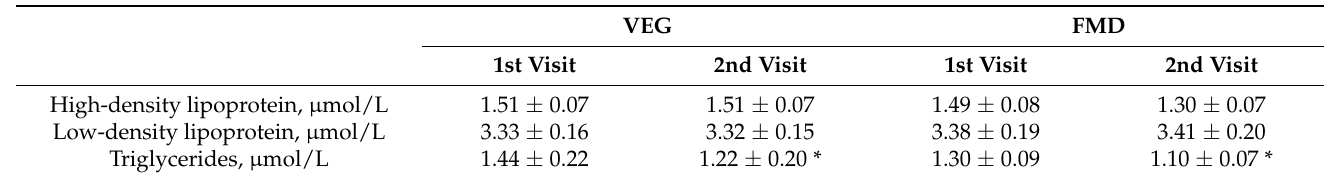
Table 2. The effects of a 5-day regular diet supplemented with 4 servings of vegetables (VEG) and fasting-mimicking diet (FMD) on the plasma lipid